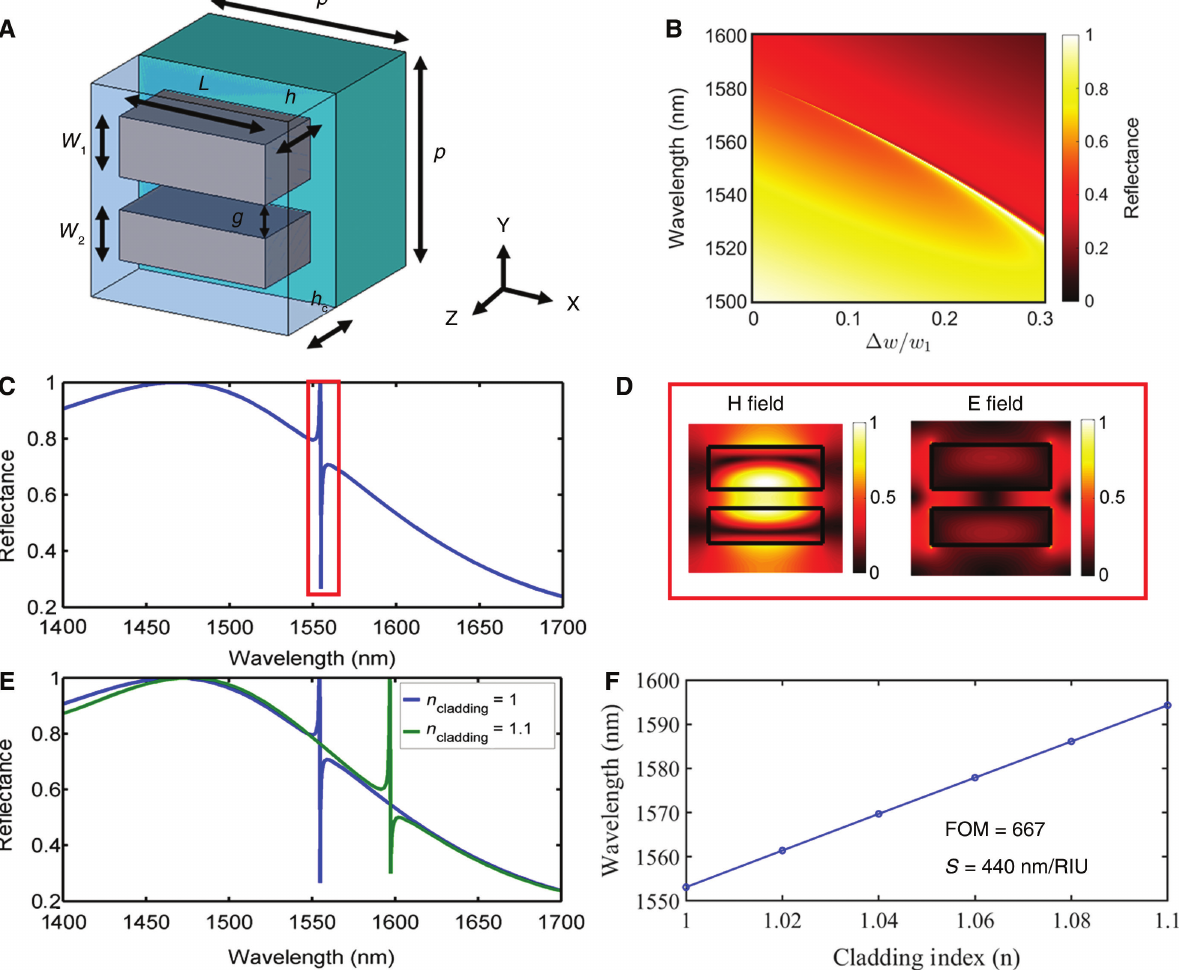
Figure 2: Numerical simulation of the quasi-BIC structure. (A) Geometry of unit cell. (B) Reflectance spectrum with respect to the asymmetry of the nanostructure at normal incidence. (C) Reflectance through the nanostructure illustrating the resonance of the mode. To have the high- Q mode at 1550 nm, we choose the appropriate geometrical parameters. (D) Simulated electric and magnetic field distributions, in which the magnetic field is strongly localized between the two bars (low refractive index) while the electric field is highly confined in the edge of the bars. (E) Simulated reflection for different cladding layers ( n = 1 and n = 1.1). (F) Resonance wavelength as a function of the refractive index of the surrounding medium, showing a high FOM of 677 and bulk sensitivity of 440